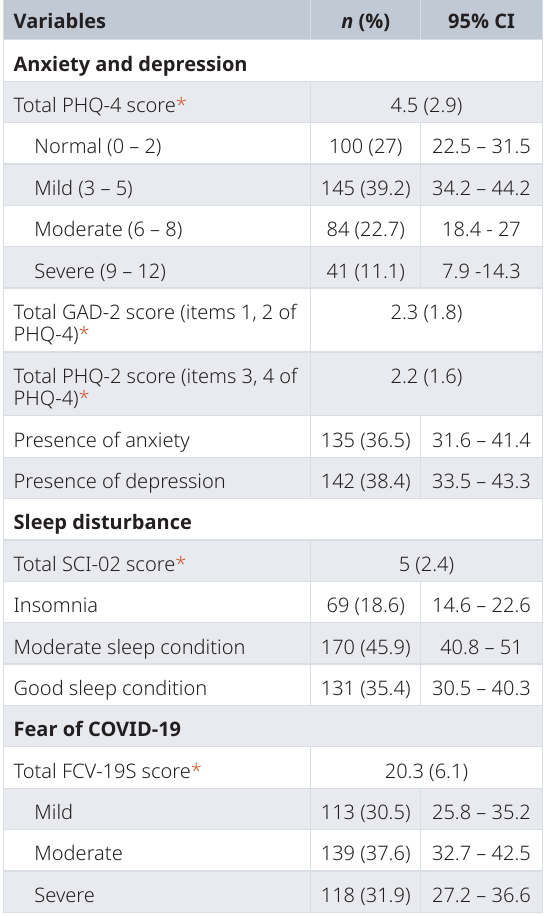
Regarding fear of COVID-19, the univariate analysis found gender (p<0.001), primary working area (p=0.002), and inad- equate resources (p=0.03) as associated factors (Table 4).